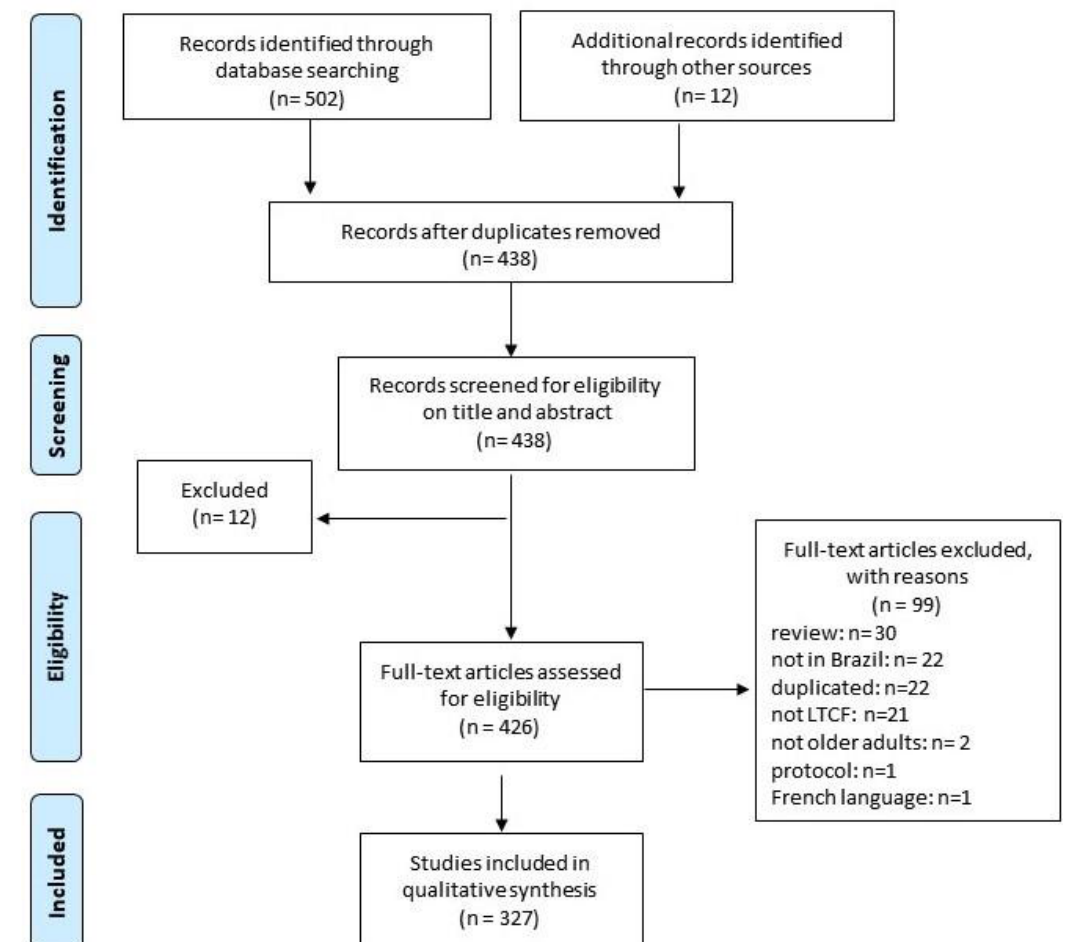
Figure 1. Flow chart with scoping review selection process.